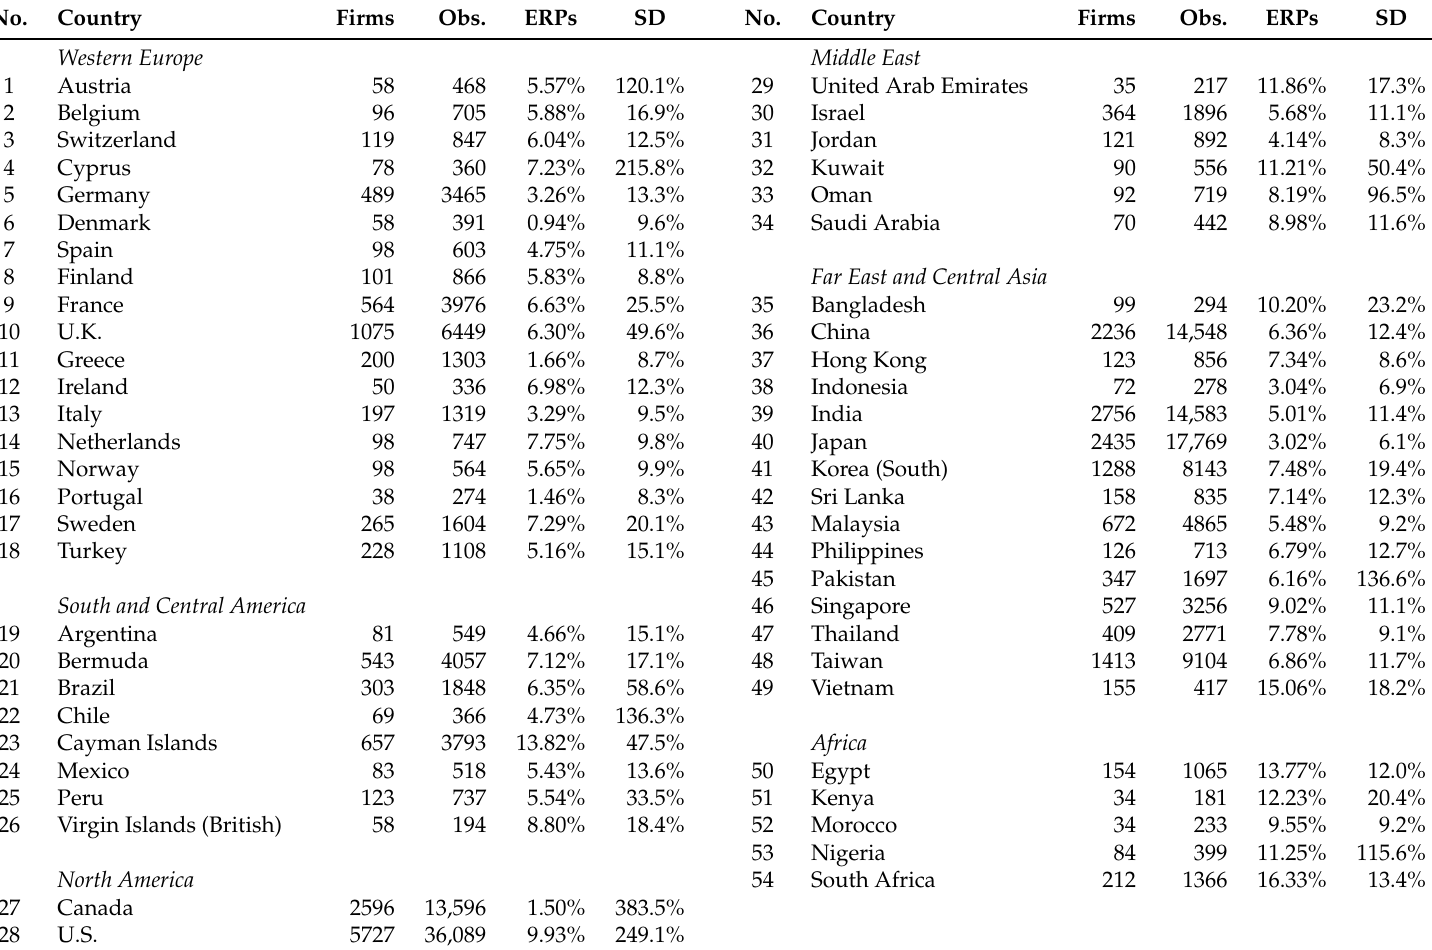
Table 2. Fundamental equity premia across